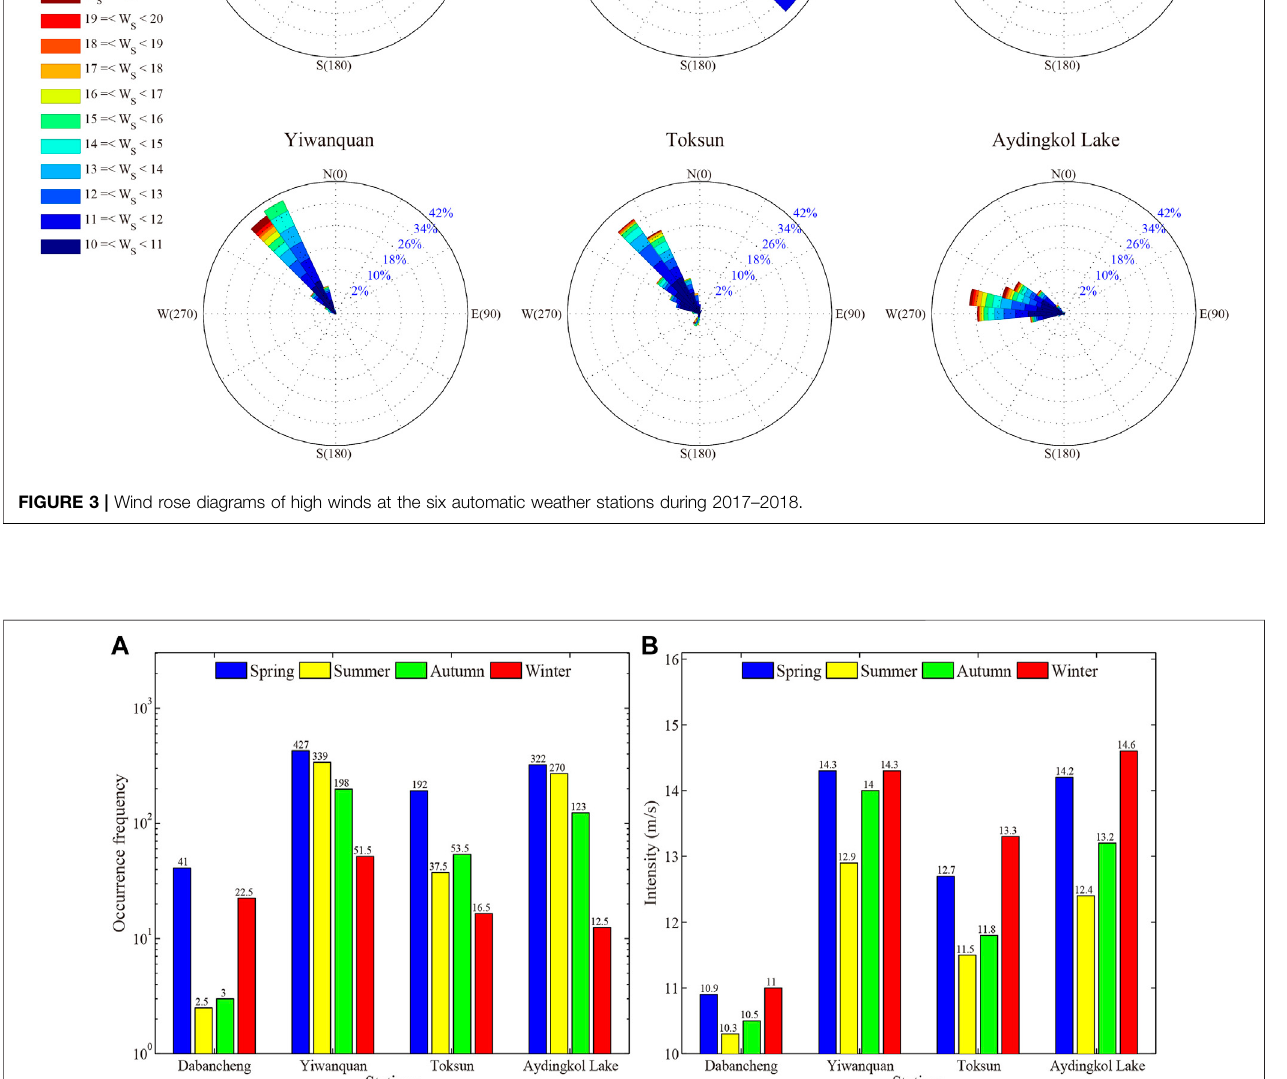
weakest (10.9 m s − 1 ), showing little seasonal variation. The mean intensities of SHWEs at Yiwanquan (13.2 m s − 1 ) and Aydingkol Lake (13.1 m s − 1 ) are comparable, which are slightly greater than that at